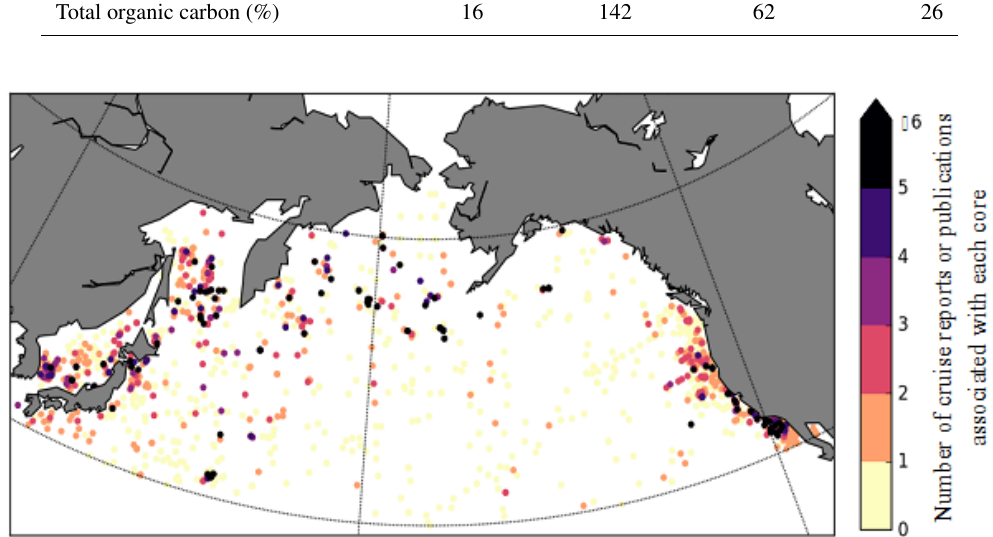
Figure 6. Number of affiliated publications and cruise reports for each core. The maximum publication count for an individual core is